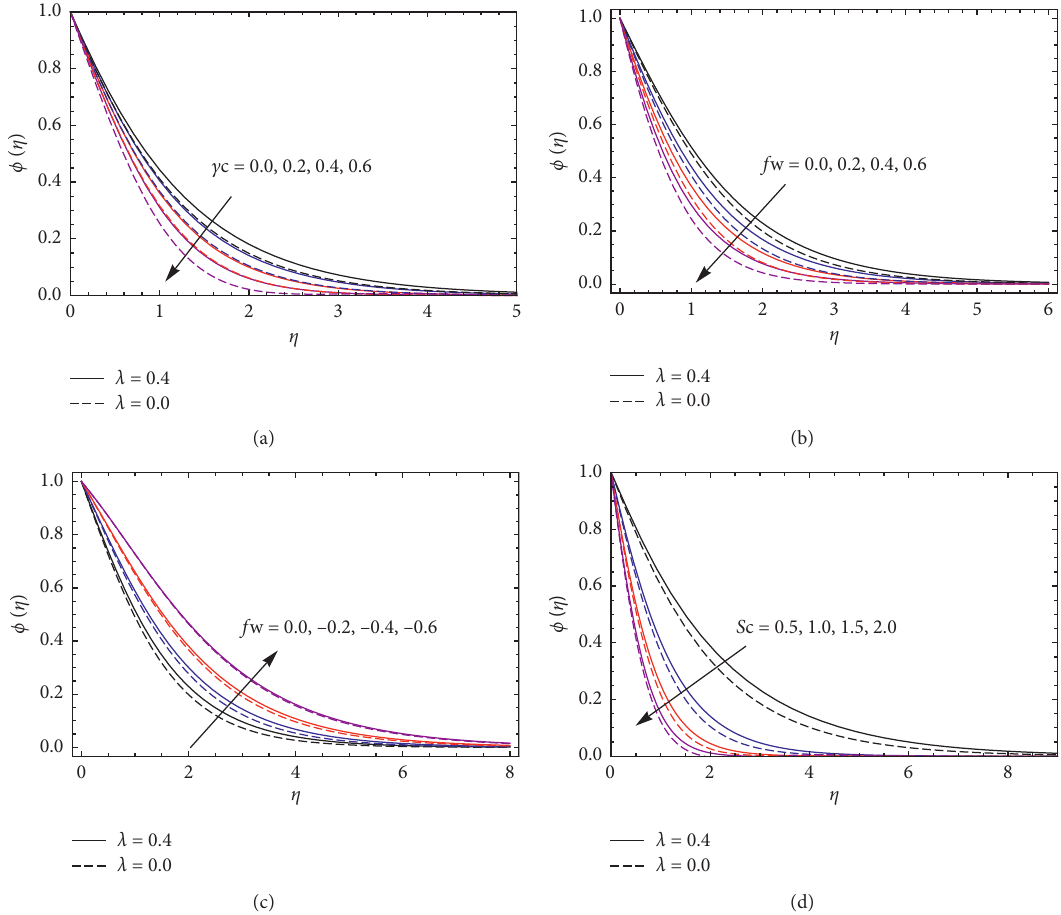
Figure 5: Impact of concentration on the different values of parameters. (a) c (c) fw � 0 . 0 , − 0 . 2 , − 0 . 4 , − 0 . 6, and (d) Sc � 0 . 5 , 1 . 0 , 1 . 5 , 2 . 0.